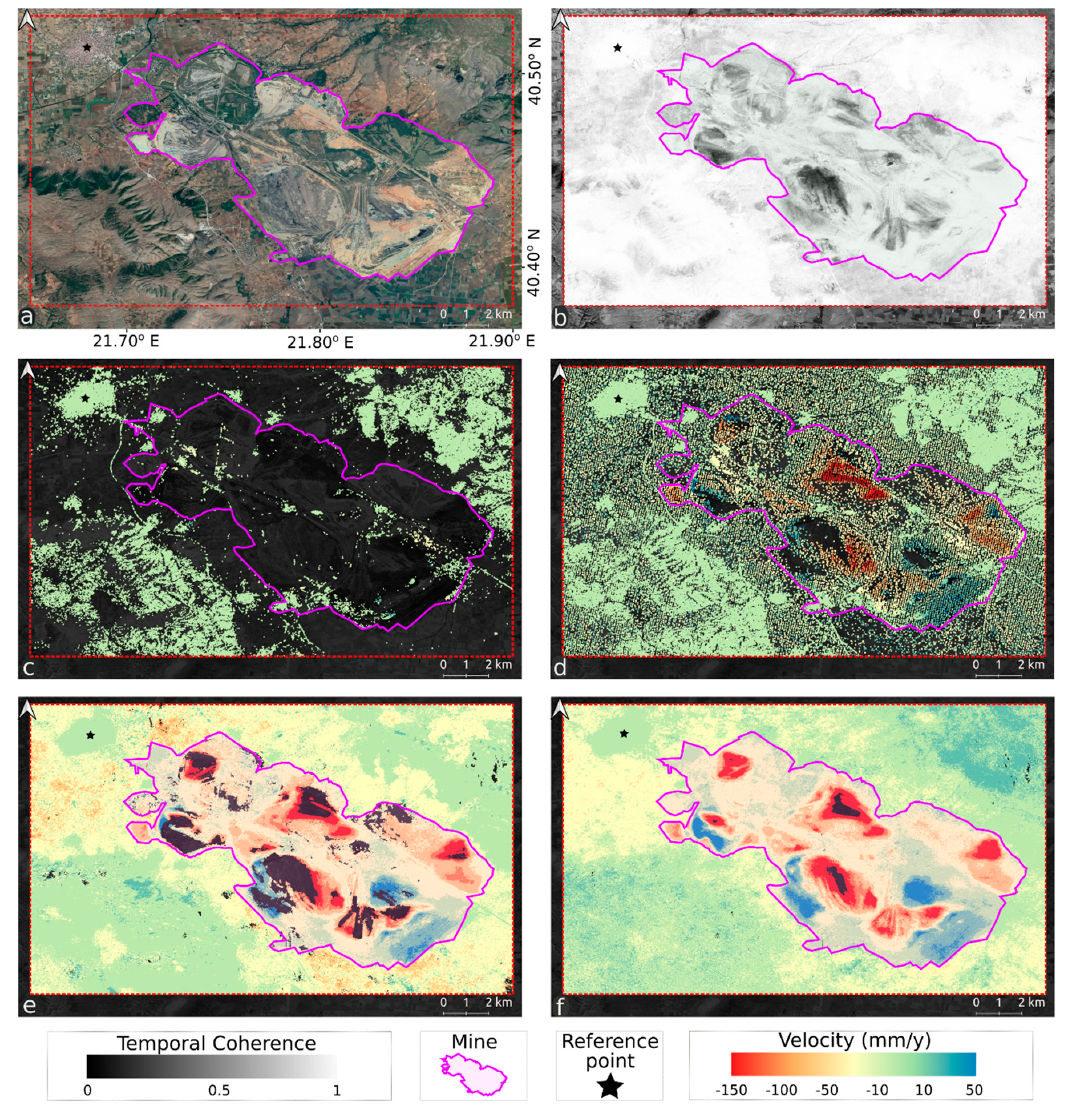
Figure 3. LOS deformation rate results of open source TSInSAR approaches. ( a ) Google earth optical image at 2018. AOI is denoted with the red dashed rectangular. Mining region is denoted with purple polygon; ( b ) temporal coherence of the SAR dataset from Mintpy; ( c ) Stamps Permanent Scatterers (PS) results; ( d ) Stamps / MTI results; ( e ) Mintpy-WSBAS results; ( f ) Giant-NSBAS results. The red color indicates subsidence while blue shows uplift. Maps a–f were created using QGIS. QGIS Development Team, 2019. QGIS Geographic Information System (Version 3.8.1). Open Source Geospatial Foundation Project. http: //